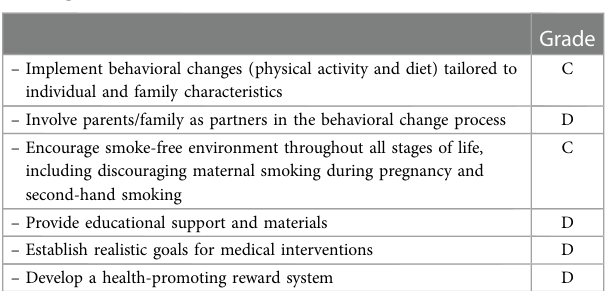
TABLE 6 Lifestyle recommendations to reduce high blood pressure values: goals.